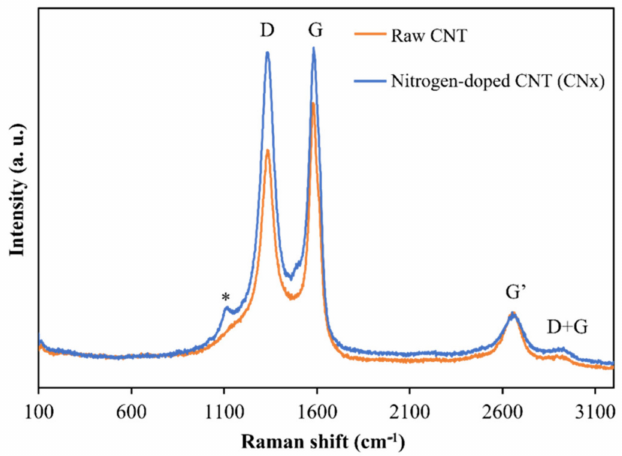
Figure 2. Raman spectra of raw and functionalized